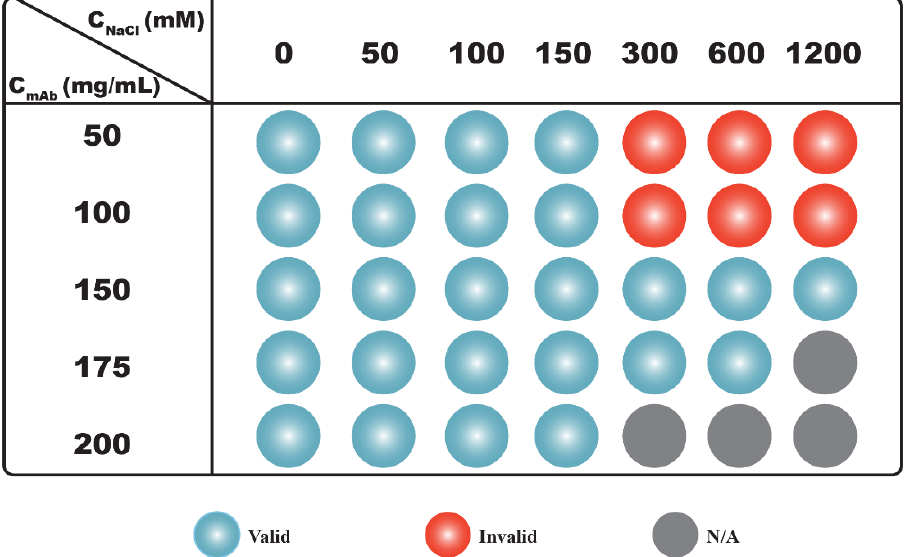
Figure 3. Correlations between k D and S (0) eff values. Conditions under which k D is greater than − 8 mL/g and S (0) eff value is less than 1 are represented with blue spheres. Under these conditions, both parameters suggest the net PPI are repulsive. Conditions under which k D is greater than − 8 mL/g, but S (0) eff is greater than 1 are represented with red spheres. Under these conditions, k D values suggest net PPI are repulsive, while S (0) eff values suggest the net PPI are dominated by attractions. Experimental conditions under which mAb samples are not prepared/measured are shown in grey.